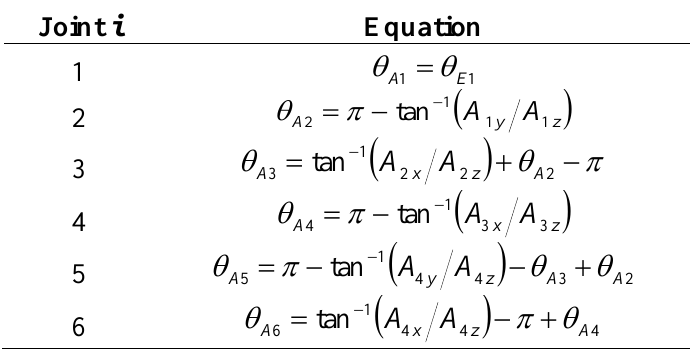
Table 1. Equations to estimate the angular position of each joint using accelerometers.